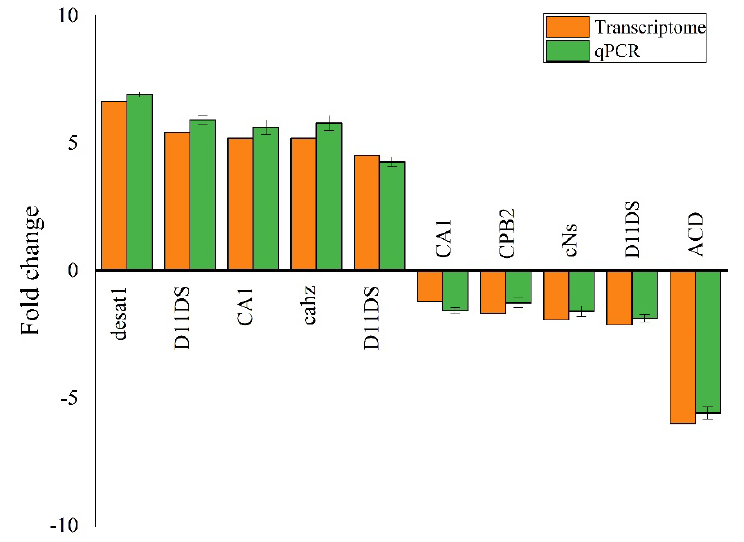
Figure 7. Quantitative PCR (qPCR) authentication of the DEGs associated with detoxification indox- acarb in Solenopsis invicta .